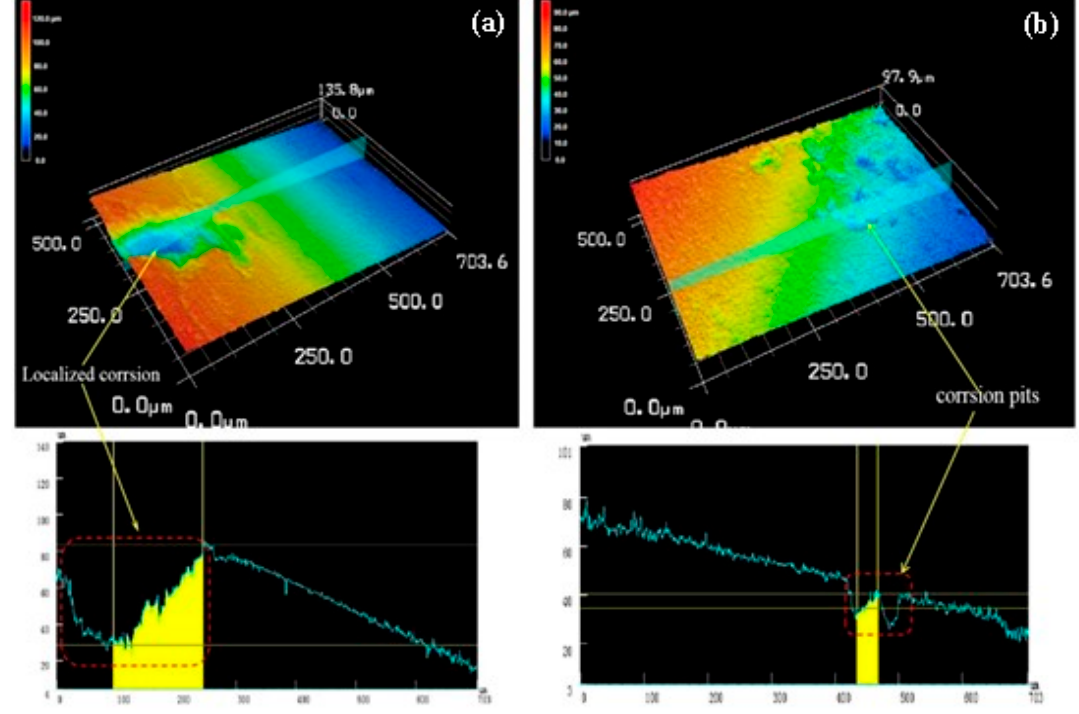
Figure 16. Both ( a ) and ( b ) were three-dimensional corrosion morphology of extruded alloy (350 ◦ C) after corrosion product removal.